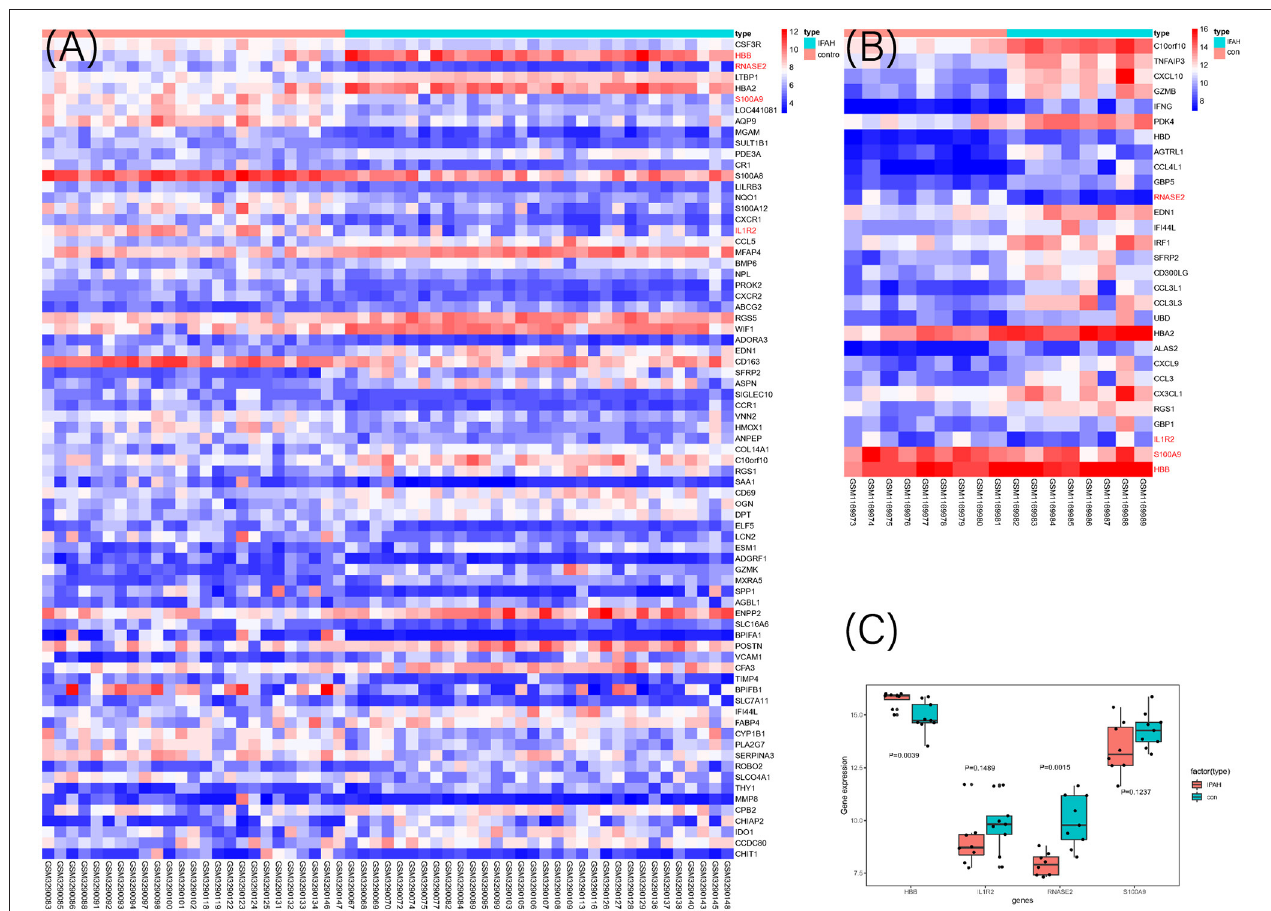
FIGURE 6 | The heat map of DEGs in discovery cohort (A) and validation cohort (B) between IPAH and the control group. The selected four genes were marked as red color; (C) The expression value of the identified four genes in the validation cohort.